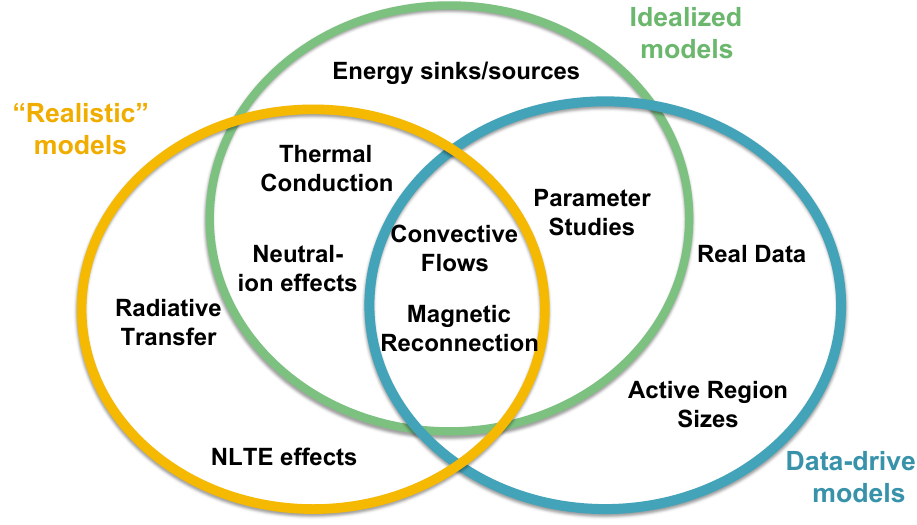
Figure 5: Models of magnetic flux emergence can be roughly divided into three categories, though there are large areas of overlap between them. So-called ‘realistic’ models attempt to include all the known important physical ingredients, while idealize models generally focus on studying a more limited set of effects. For case studies of certain observed emerging flux studies, data-driven models are